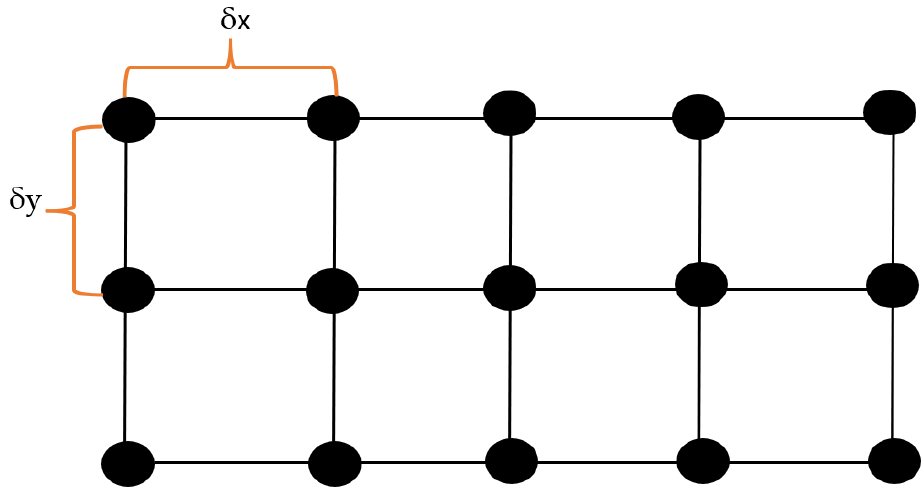
Figure 6. The placement and the connections of the RSUs in a given